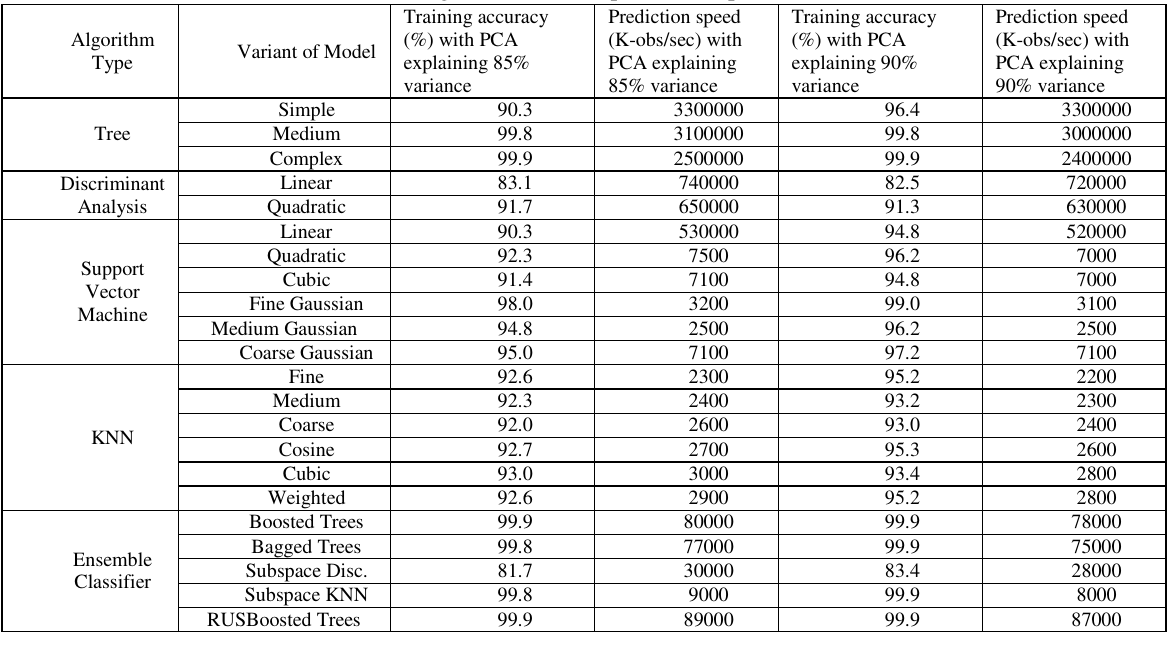
Table 5: Training accuracies and prediction speeds with PCA Algorithm